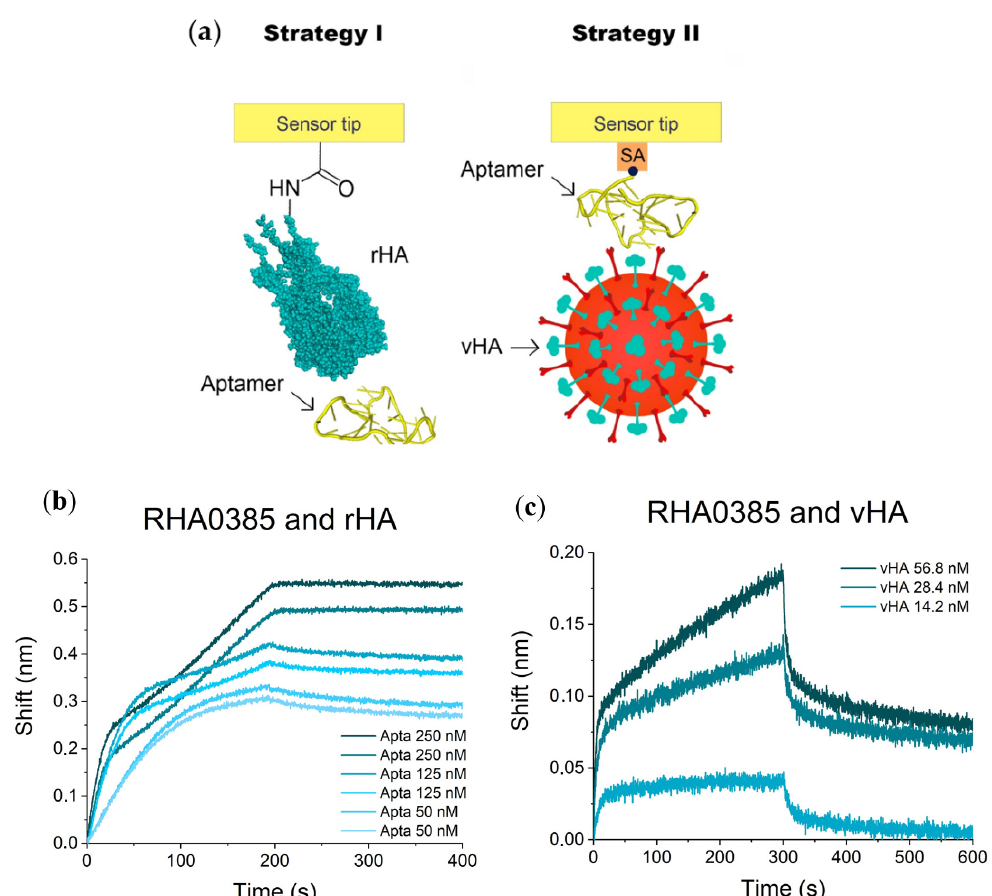
Figure 2. BLI binding assays of aptamer to HA of influenza A virus: ( a ) two strategies of the experiment with immobilization of recombinant HA and immobilization of the aptamer. Influenza virus picture was taken from Kisscc0 website [24]; sensorgrams for the complex of RHA0385 aptamer with ( b ) rHA and ( c ) vHA.